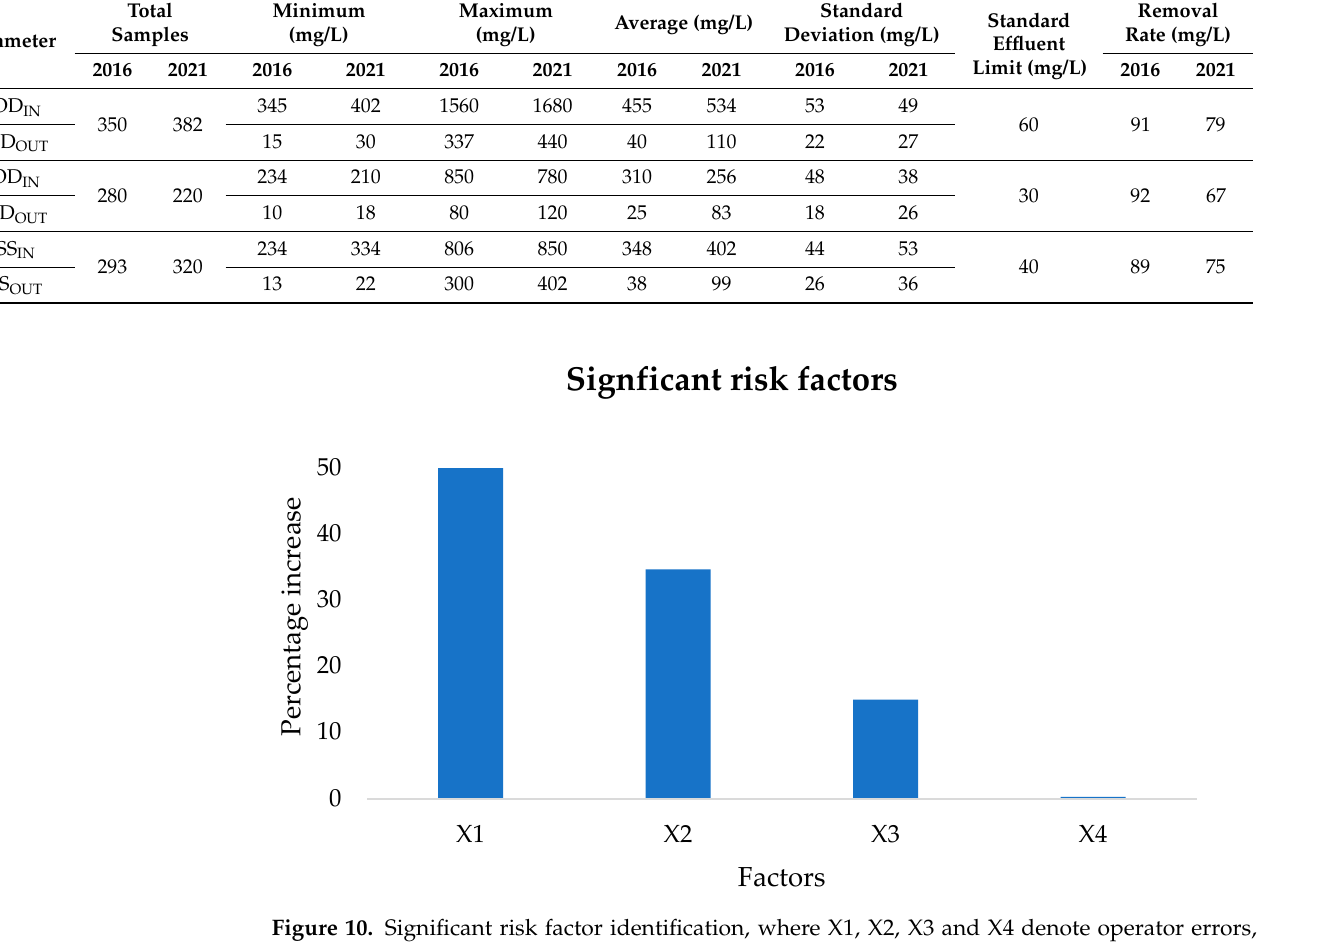
Table 5. The proposed risk-mitigating measures of the MIC WWTP. Risk Factors